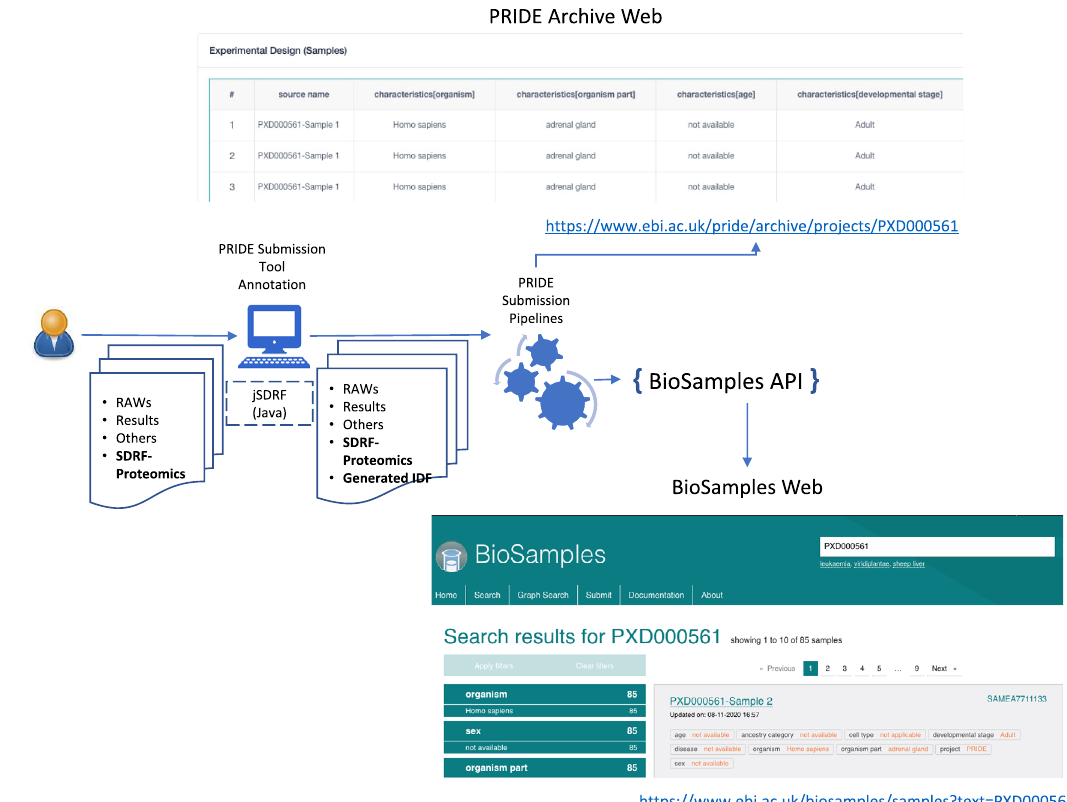
Fig. 4 PRIDE database-submission work fl ow supporting IDF and SDRF fi les. The IDF fi le is automatically generated during submission; the SDRF fi le can be provided by the user in the PRIDE Submission Tool and is automatically validated in the submission pipeline. The sample information is shown on the web page of each PRIDE dataset and submitted to the EBI BioSample database, which assigns a unique accession to each sample. Shown are representative PRIDE and BioSamples outputs for the dataset